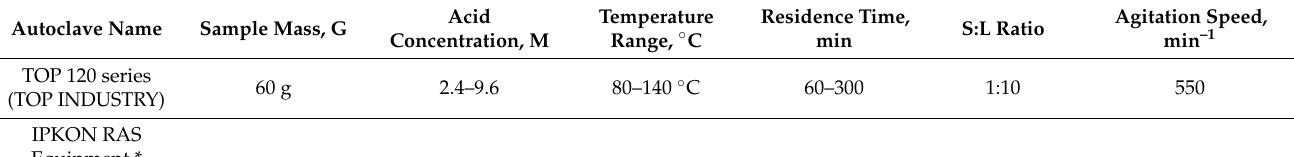
Table 2. Leaching